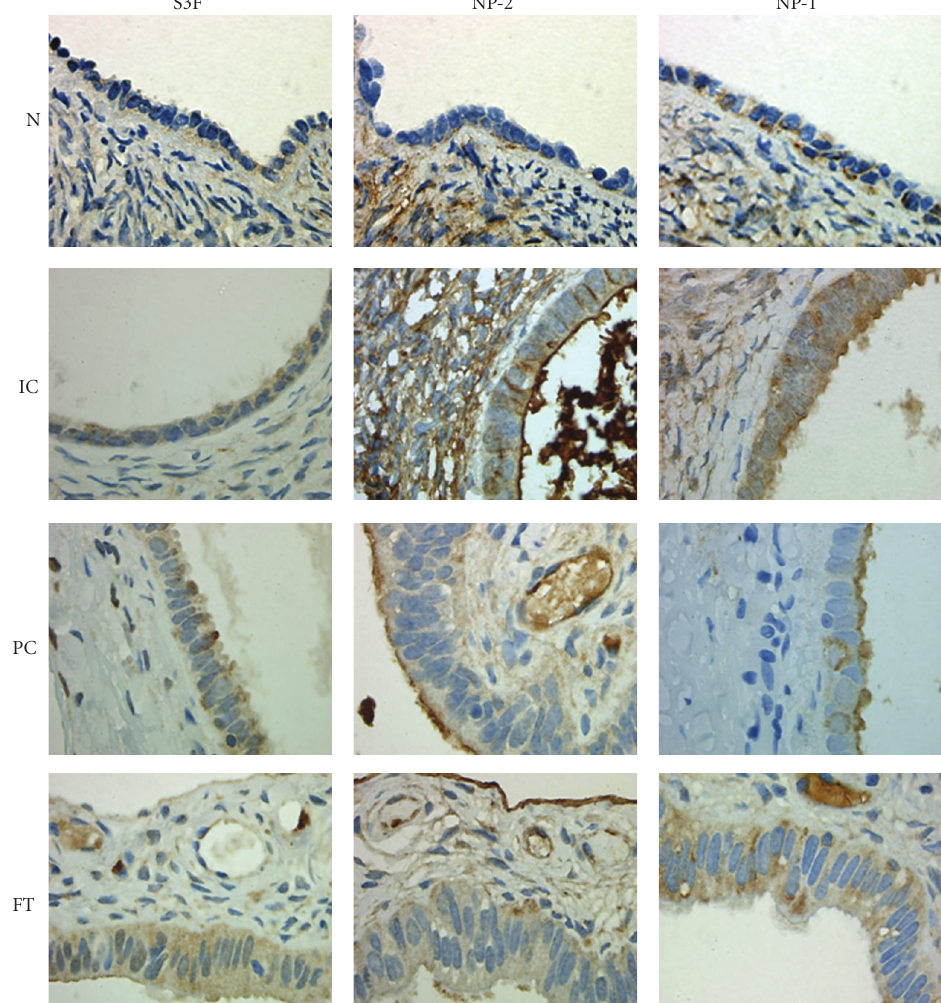
Figure 4: S3F expression is elevated in inclusion cysts, paraovarian cysts, and fallopian tubes. Representative illustrations of immunohistochemical staining of normal ovary (N), inclusion cyst (IC), paraovarian cyst (PC), and fallopian tube (FT) for S3F, NP-2, and NP-1. Original magnification is 400 ×